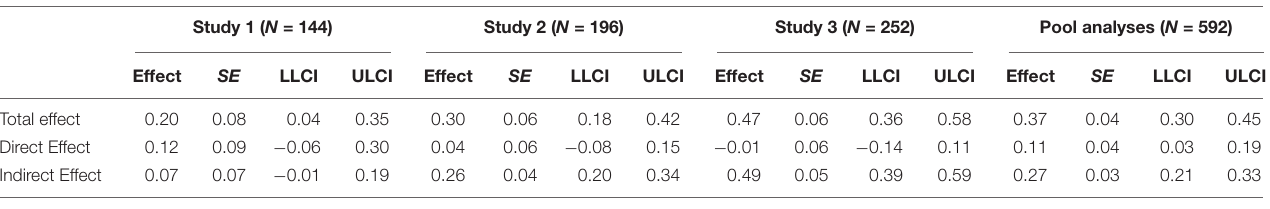
TABLE 4 | Summary of total, direct and indirect effect of feminist identification and benevolent sexism on men’s future intentions to confront Studies 1-3 and pooled analyses. Relationship between Feminist Identification and men’s future intentions to confront via egalitarian motivation Study 1 ( N =